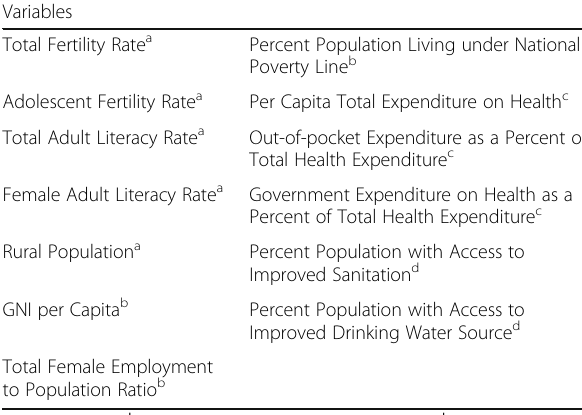
Table 2 Independent Variables and their Respective Classes